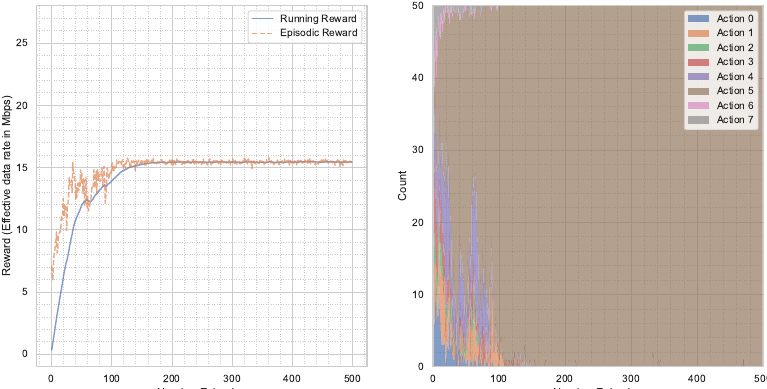
Figure 9. The behavior of the PPO reinforcement learning approach on an AWGN channel with a static SNR of